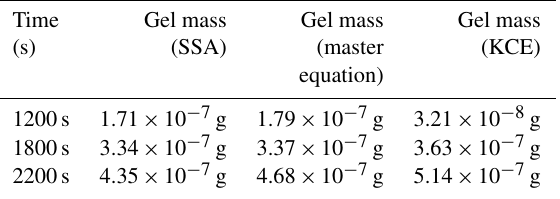
Table 2. Expected gel mass calculated from the SSA and the master equation. Simulations were performed for the hydrodynamic kernel.